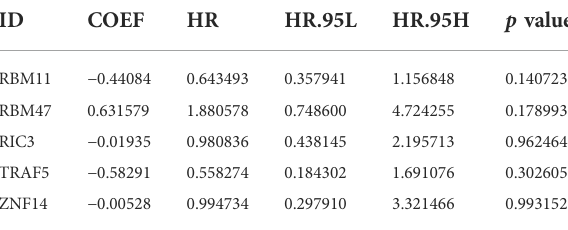
TABLE 2 The result of multivariate COX regression